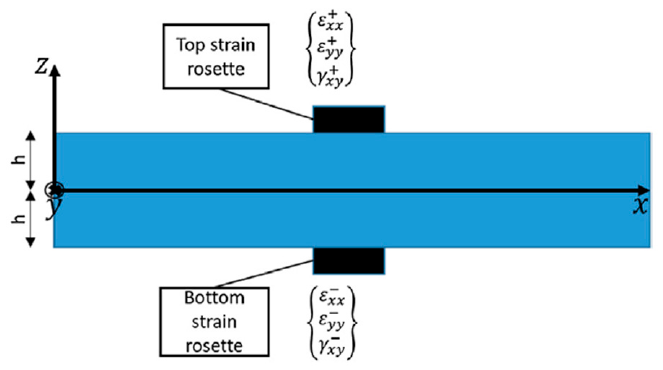
Figure 2. Discrete sensor location on the shell structure.